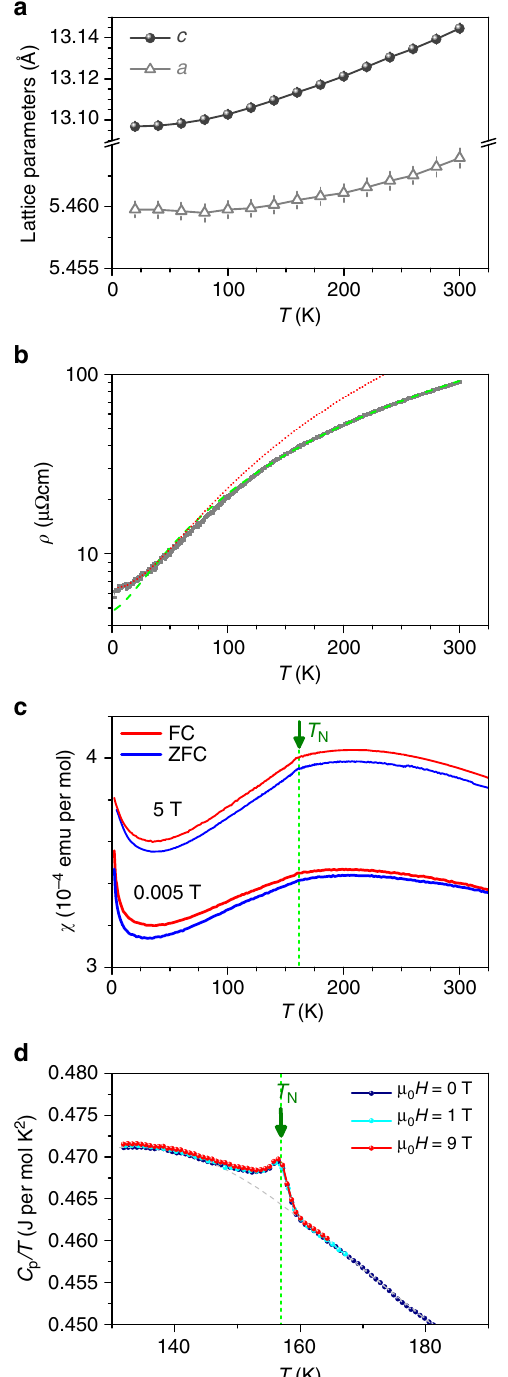
Fig. 2 Temperature dependence of physical properties of LaNiO 3 . a Lattice parameters of our LaNiO 3 as a function of temperature (space group R 3 c ). The error bars are the standard deviations obtained from Rietveld re fi nement using the Fullprof software. b Electrical resistivity of LaNiO 3 (gray). The red line indicates a fi t to ρ 0 þ AT n (for T < 35K) and the dashed green line is a fi t over the entire temperature range. c Magnetic susceptibility of LaNiO 3 under fi eld cooled (FC) and zero- fi eld cooled (ZFC) conditions for applied fi elds of μ H = 0.005T and 5T. The high- and low- fi eld measurements both together 0 indicate an antiferromagentic transition at T N that is an intrinsic property of LaNiO 3 . d Speci fi c heat measurements of LaNiO 3 in fi elds of 0T, 1T, and